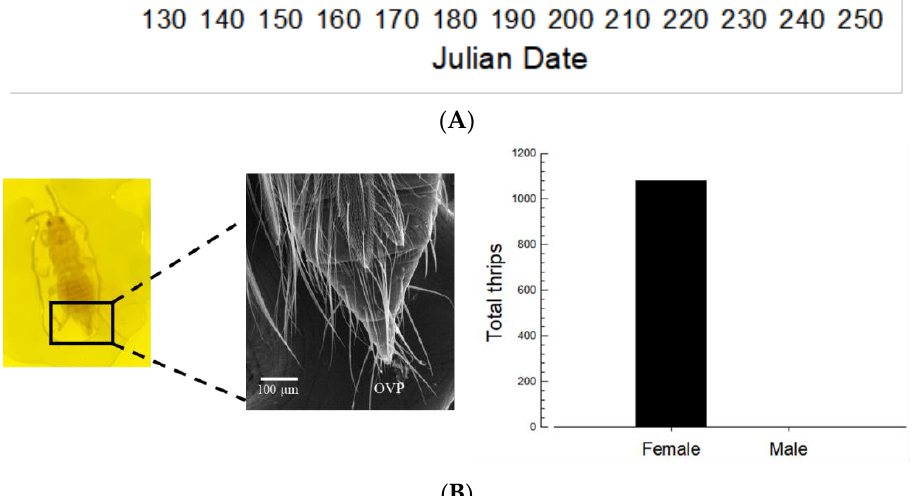
Figure 1. Seasonal occurrence of T . tabaci in Welsh onion fields. Onions were transplanted in early May. Monitoring traps were installed on 20 May 2021 using yellow sticky plates, and the number of captures was counted every week. Three traps were placed at each field. Onions were harvested at the end of August. ( A ) Occurrence of onion thrips, T . tabaci , per trap in three different fields in Andong, Korea. Three fields were separated by more than 1 Km. Error bar indicates standard deviation. ( B ) Biased sex ratio of onion thrips collected from fields. Ovipositor (‘OVP’) was used to discriminate females. Left panel shows both stereomicroscope (50×) and SEM (5000×) photos. Right panel indicate sex analysis of total collections from three fields.